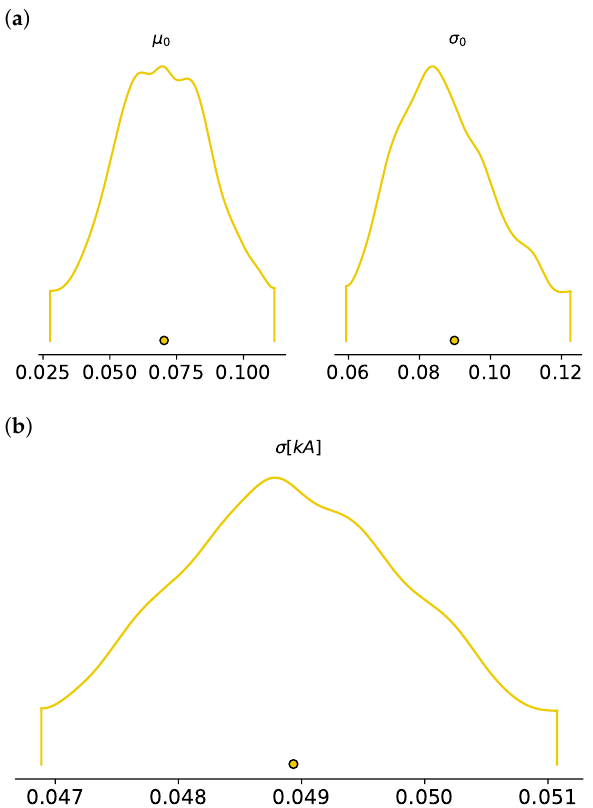
Figure 6. Kernel density estimators of ( a ) hyper-parameters µ 0 , σ 0 (which have no units) and ( b ) standard error of current measurement (kA) also show reasonable sampling behavior. However, flat middle of µ 0 distribution and ‘triangular’ shape of σ might suggest some